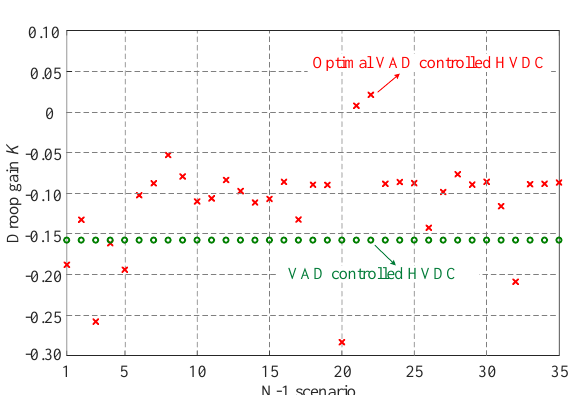
Fig. 5. The results of droop gain K under the VAD controlled HVDC and optimal VAD controlled HVDC.